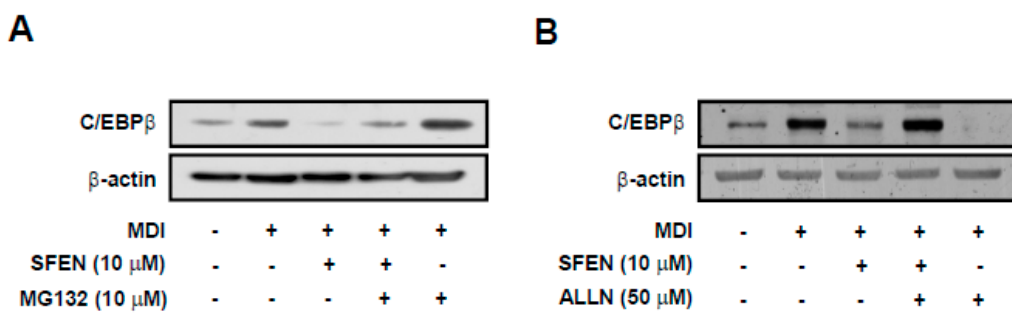
Figure 5. E ff ect of sulforaphene (SFEN) on the degradation of C / EBP β in 3T3-L1 pre-adipocytes. ( A ) Western blot analysis of C / EBP β protein (35 kDa) and β -actin (43 kDa) as a housekeeping gene expression levels after treatment with 10 µ M MG132 (proteasome inhibitor) for 2 h and ( B ) after treatment with 50 µ M ALLN (calpain inhibitor) for 1 h. 3T3-L1 pre-adipocytes were seeded in 6 cm dishes at a density of 0.75 × 10 4 cells per cm 2 . Confluent cells were incubated for two days in mouse adipocyte di ff erentiation medium (MDM) with or without 10 µ M SFEN. ( A ) After two days,